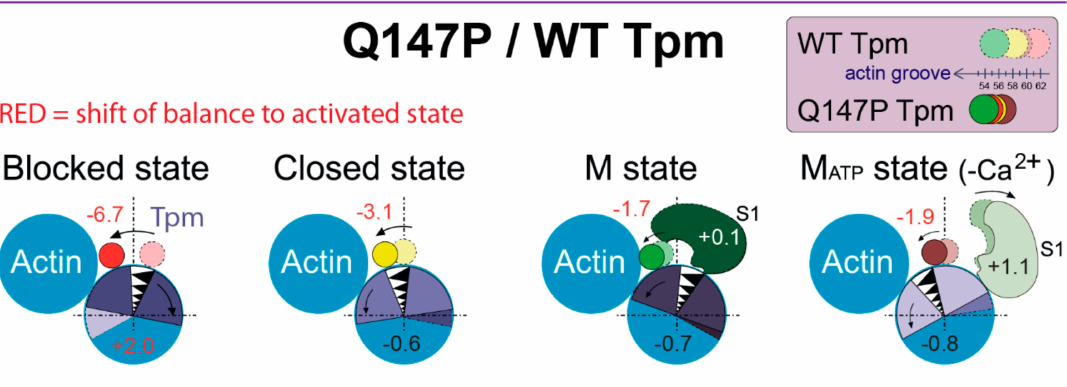
Figure 4. The schematic view of the changes in the conformational rearrangements of actin monomers and the myosin heads and in the position of Tpm caused by the congenital-myopathy-causing mutation Q147P in Tpm2.2. The muscle fibers contained Tpm and troponin at a low Ca 2 + concentration (simulated blocked state), at a high Ca 2 + concentration (closed state) or Tpm, troponin and S1 in the absence of nucleotide (M state) and in the presence of ATP (M ATP state). Several proposed positions of Tpms related to the values of Φ E are shown on top. The numbers close to Tpm, actin, and the myosin head are used to designate the changes under the substitution in the values of Φ E for actin-FITC, Tpm-AF and S1-AEDANS as compared with the respective changes in the presence of WT